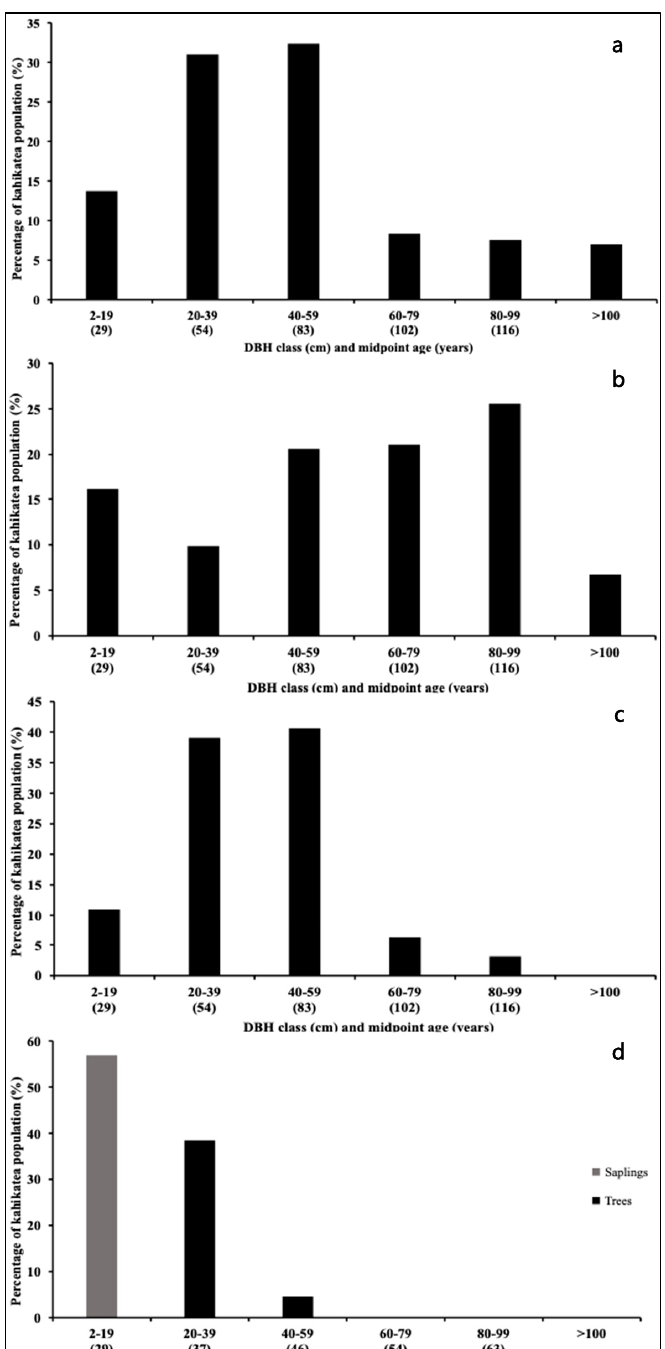
Figure 2. Kahikatea (A.Rich.) de Laub. stand DBH classes (percentage of population) and predicted midpoint age of Te Papanui n = 371 ( a ), Hillcrest Park n = 223 ( b ), Grove Park n = 64 ( c ) and Totara Park n = 65 ( d ). Size class data for Te Papanui (the reference site) was sourced from a previous study [37]. Ages were predicted from the J.R. Leathwick (unpublished) regression equation for Te Papanui, Hillcrest Park and Grove Park, although the midpoint age of their smallest size class was calculated from the D.A. McLean (unpublished) regression equation because it is a better predictor of the age of small kahikatea. Data were used from a previous study [49] for Totara Park’s age structure, and ages were predicted using the D.A. McLean (unpublished) regression equation.